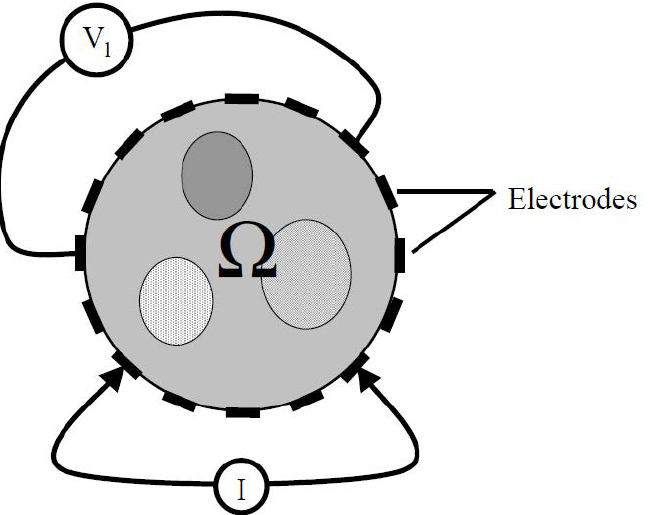
Figure 1. Vessel with object of study Ω . There are 16 electrodes around the vessel, I represents the current injected, and V 1 the voltage measurements and Ω represents the sample core, taken from